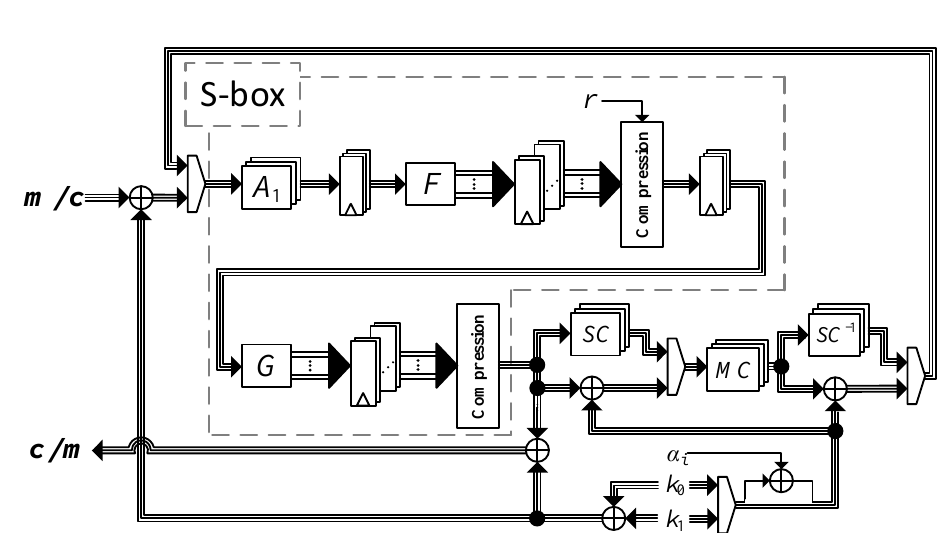
Figure 3: Design architecture of our round-based second-order Midori-64 encryp- tion/decryption